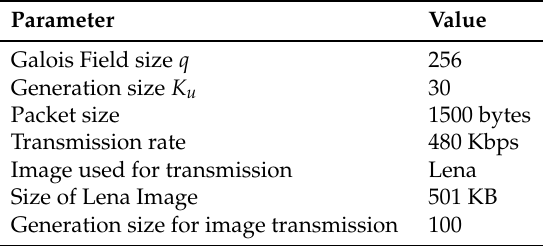
Table 2. Simulation parameters.